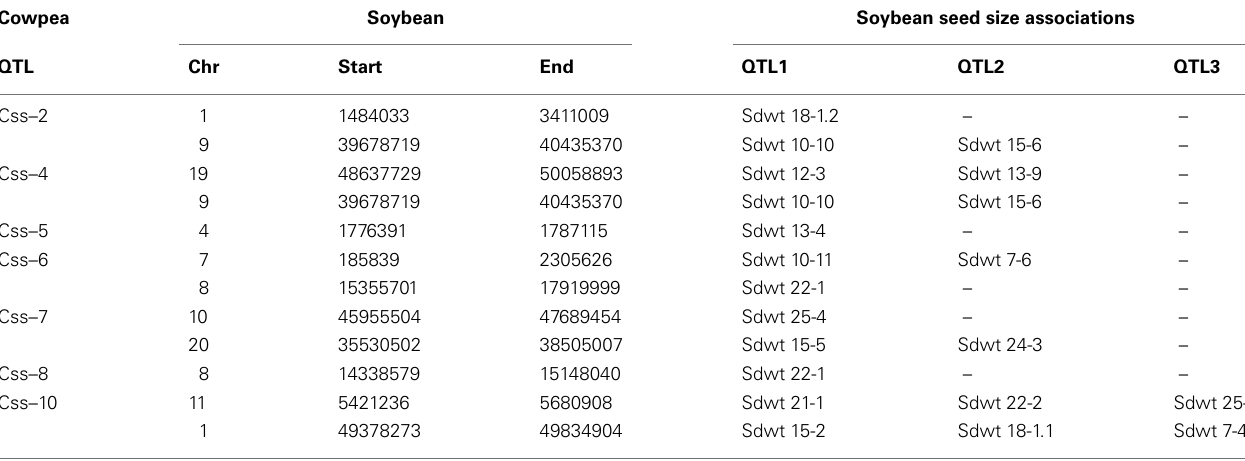
Table 3 | Seven QTL controlling the inheritance of seed size in cowpea are syntenic to regions with known association to seed size in soybean. Cowpea Soybean Soybean seed size